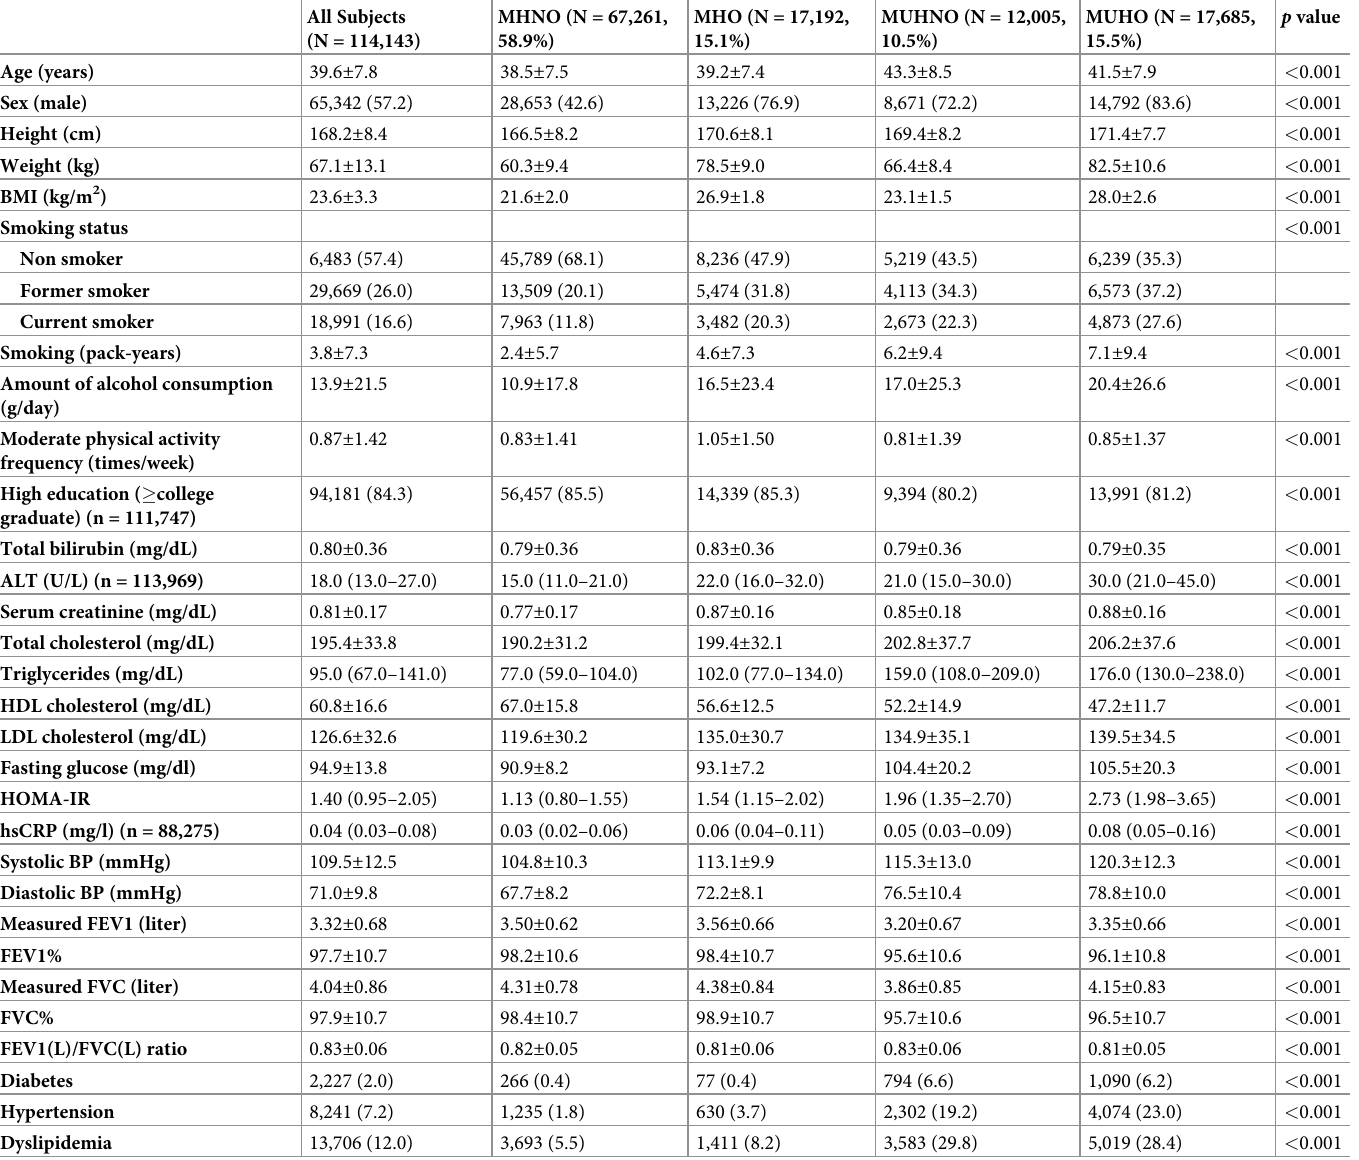
Table 1. Baseline characteristics of study participants classified by metabolic health and obesity status. All Subjects (N =